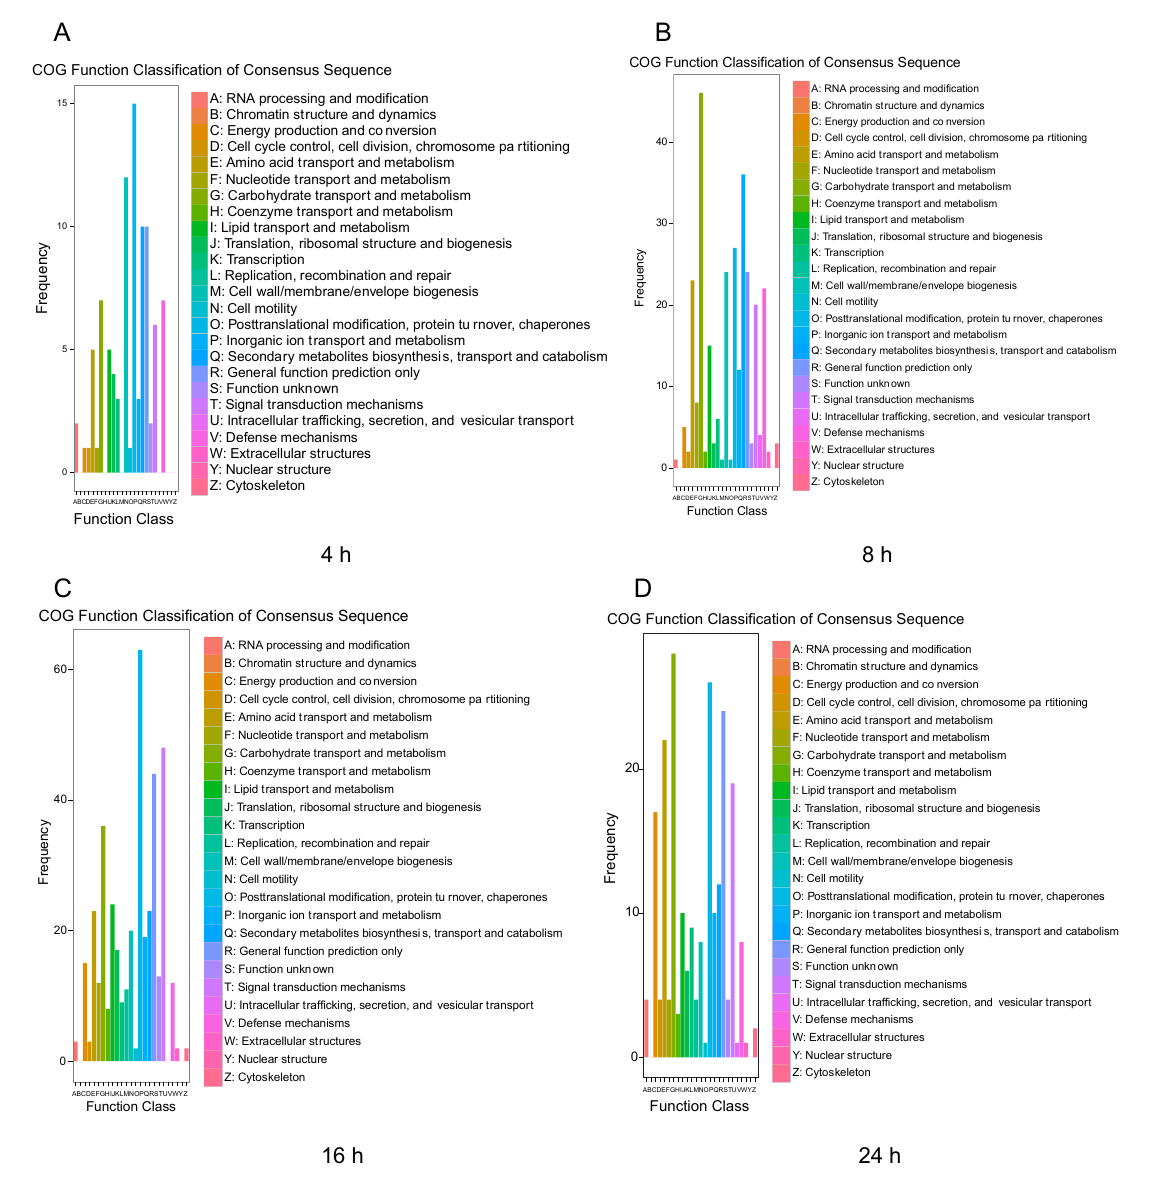
Figure 2. Clusters of orthologous groups of proteins (COG) classification of N. lugens DEGs after challenge with M. anisopliae at different periods. A: COG classification of N. lugens DEGs after challenge with M. anisopliae at 4 h; B: COG classification of N. lugens DEGs after challenge with M. anisopliae at 8 h; C: COG classification of N. lugens DEGs after challenge with M. anisopliae at 16 h; D: COG classification of N. lugens DEGs after challenge with M. anisopliae at 24 h.